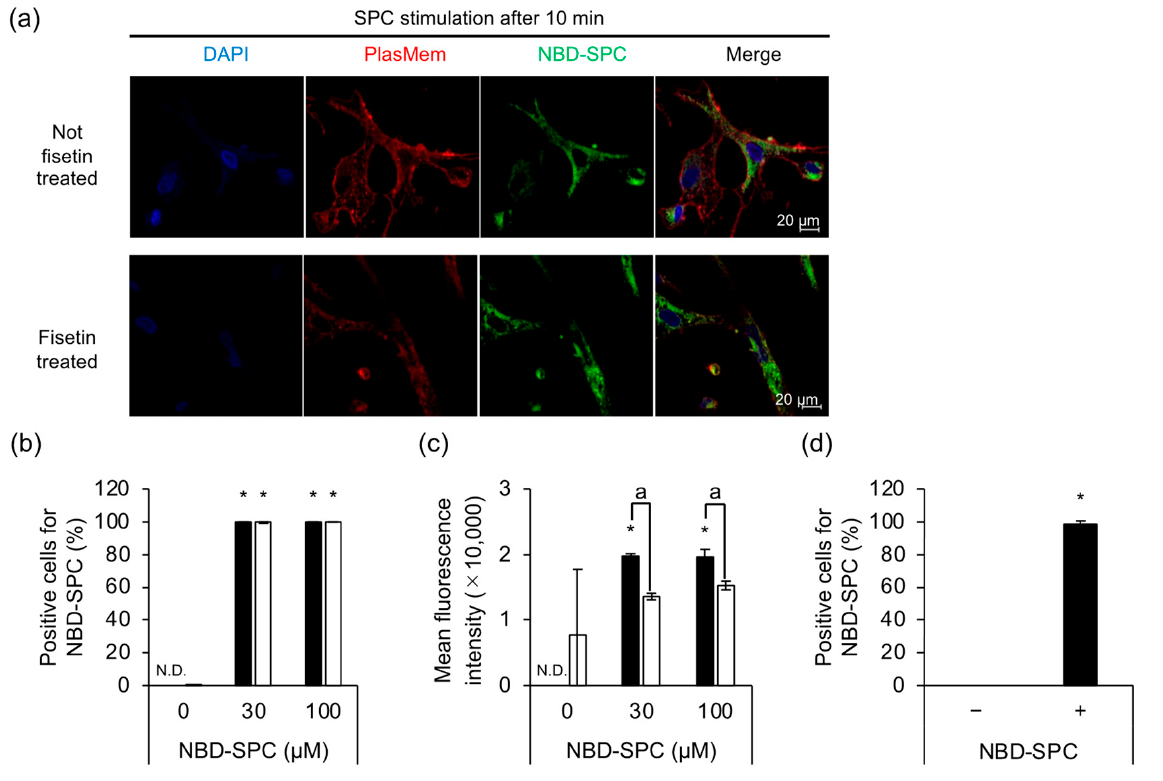
Figure 3. Localization of sphingosylphosphorylcholine (SPC) in human coronary artery smooth muscle cells (HCASMCs). ( a ) Representative image of NBD-SPC (green) localization in abnormally contracting HCASMCs. DAPI (blue), nuclear stain; PlasMem Bright Red (Red), plasma membrane stain. The top and bottom rows depict untreated control (Ctrl) cells and fisetin-treated cells. ( b ) Percentage of positive cells for NBD-SPC. Black and white indicate the number of abnormally contracting and non-contracting cells. ( c ) Mean fluorescence intensity of NBD-SPC. ( d ) Flow cytometric analysis of NBD-SPC-positive cells treated with 5 mM of M β CD. * p < 0.05 vs. 0 μ M NBD-SPC-treated cells and a: p < 0.05 vs. abnormally contracting cells. N.D. = not detected. Data are represented as mean ± standard deviation.